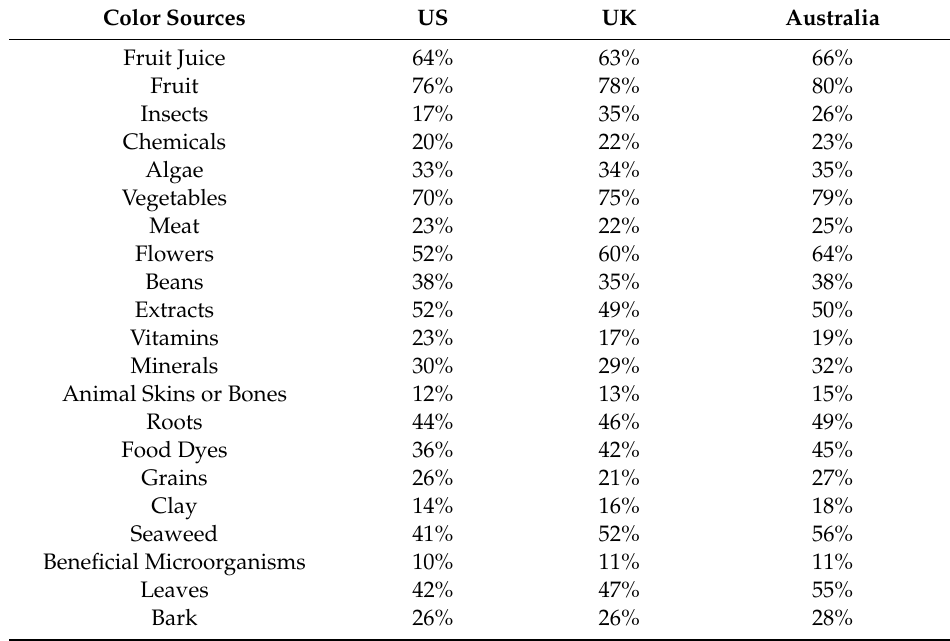
Table 4. Percentages of US, UK, and AUS respondents rating various color sources as acceptable for natural foods and beverages.